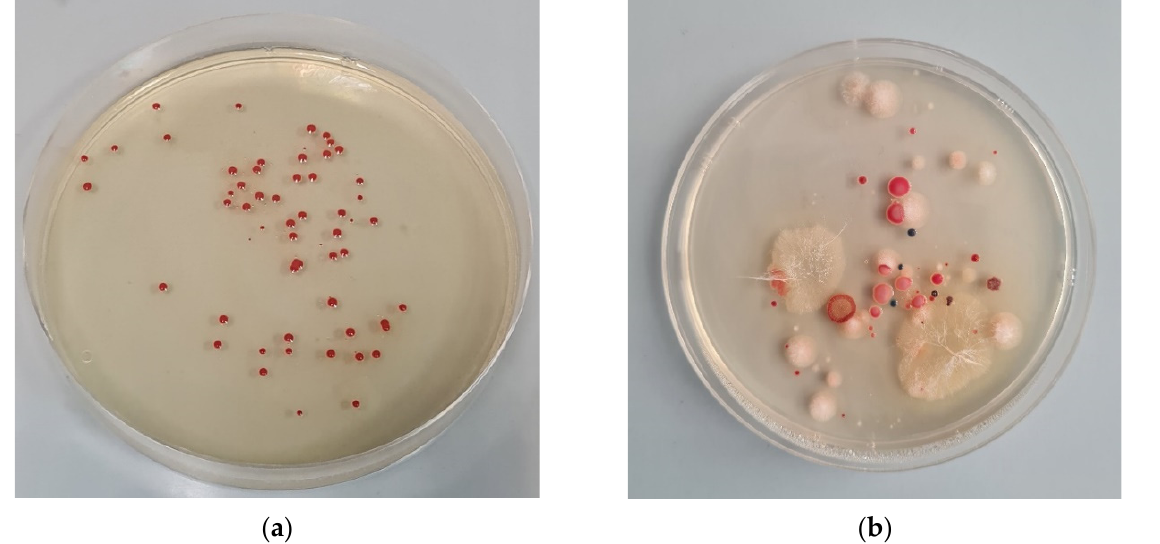
Figure 3. ( a ) Colonies of carbapenem-resistant bacteria (CRB) grown on CHROMagar Acinetobacter; ( b ) in some cases, colonies of fungi grew on CHROMagar Acinetobacter after two days of incubation, but they did not hinder the enumeration of